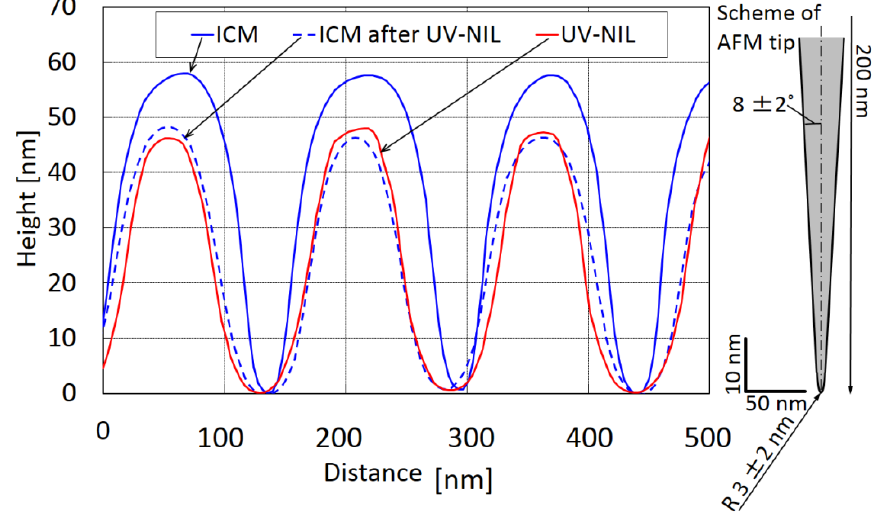
Figure 5. AFM images of the 150-nm-pitch patterns of injection-compression-molded replica (sample COP-1), after use in UV-NIL, and UV-cured resist. The scheme of AFM tip used is illustrated with the same scale of the